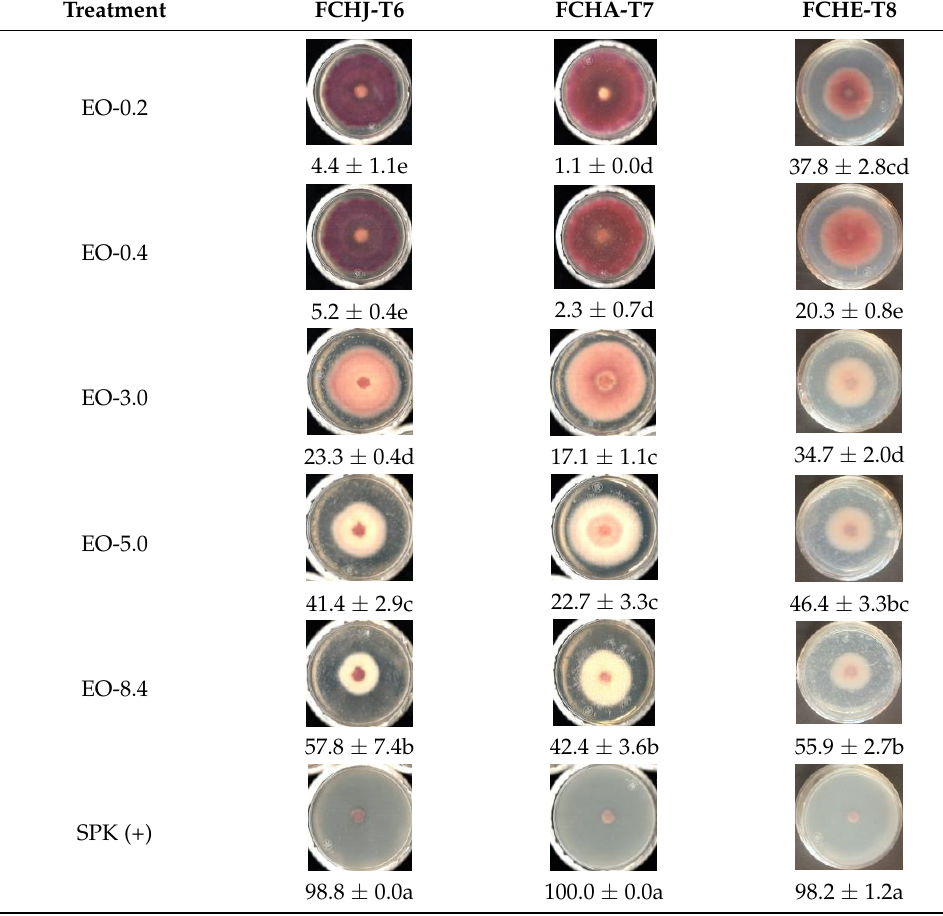
The values are presented in percentage of inhibition of radial growth and correspond to the average of three repetitions ± standard error. Values with different letters in the same column are different ( p ≤ 0.05). H 2 O (−): negative control (sterile distilled water); EO: essential oil from the P. auritum aerial part, the numbers after the dash indicate the concentration in mg/mL at which it was tested; and SPK (+): positive control (prochloraz, Sportak ® ). Table 6. Fungitoxicity of aerial part essential oil of P. auritum on Fusarium spp. Fungal Strains